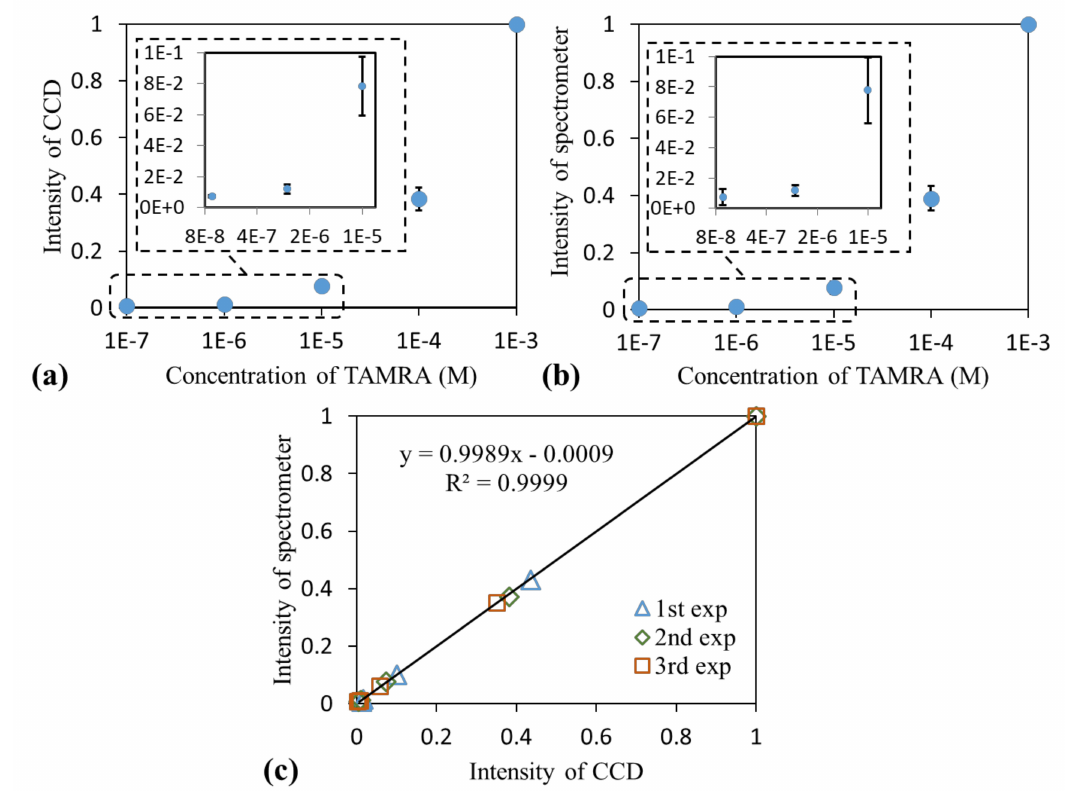
Figure 4. Dose response curve obtained using the ( a ) GGP-GMR/CCD system and ( b ) spectrome-193 ter. ( c ) This figure displays the correlation between the normalized intensity of the peak wave-194 length and that of the minimum intensity corresponding pixel (MICP).